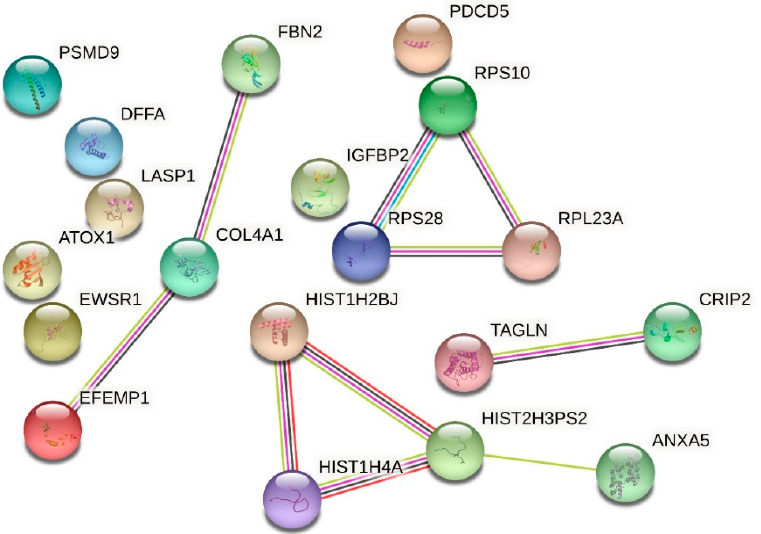
Figure 11. Network of down-regulated proteins in the HMEC-1 secretome. The network, obtained with the software STRING, includes the secreted proteins that were found to be down-regulated in cells treated with 5 g/L urea for 72 h compared to control cells.